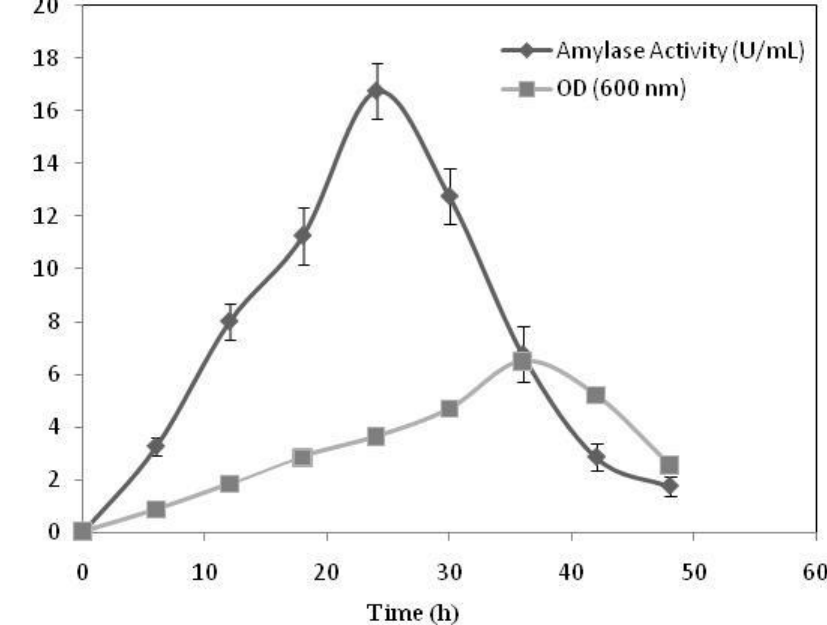
Figure 2. The time courses cell growth of Bacillus pacificus (filled square) and amylase production (filled circle). The culture was conducted at 55 °C in shaking at 150 rpm. Cell growth was monitored by measuring the absorbance at 600 nm.